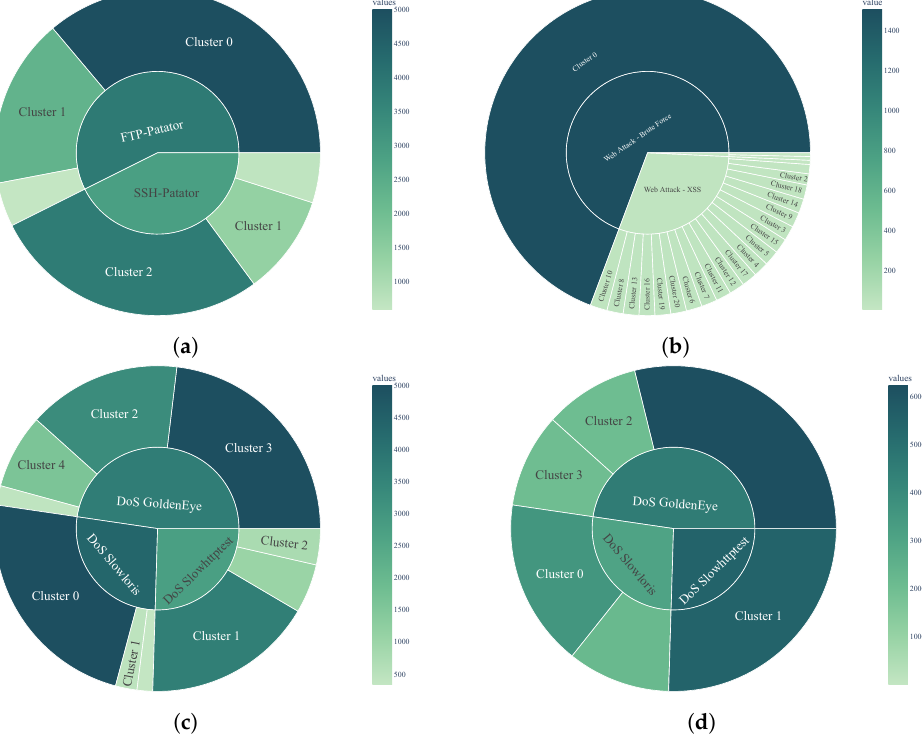
Figure 7. Sunburst diagrams for the clustering performance of ( a ) GAC on FTP and SSH Brute Force, ( b ) SOAAPR on the web attacks Brute Force (1 cluster), XSS (21 clusters) and Sql Injection (2 clusters), ( c ) GAC and ( d ) SOAAPR on the